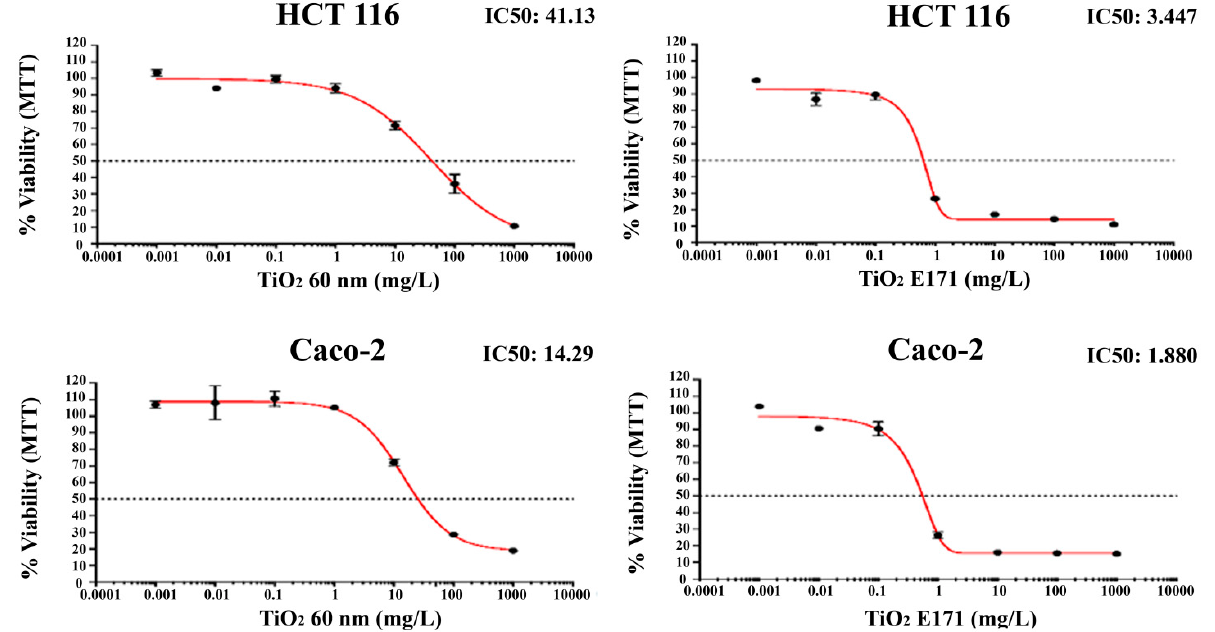
Figure 1. Inhibitory effect of TiO 2 -NPs and E171 on the growth of HCT-116 and Caco-2 cell lines. Cells’ viability evaluated through the MTT assay after 72 h of TiO 2 -NPs and E171 at different concentrations (0.0001; 0.001; 0.01; 0.1; 1; 10; 100; 1000 mg/L). Data are expressed as mean ± SD of three separate experiments.